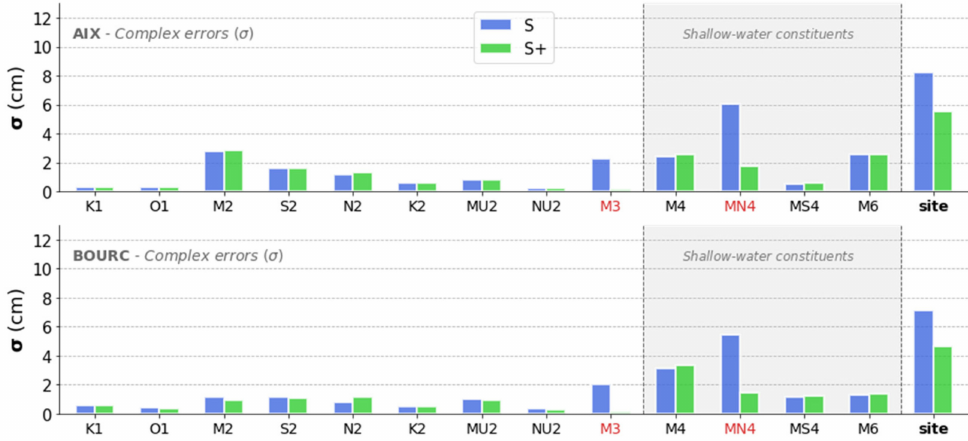
Figure 7. Complex errors for the 13 major constituents at AIX ( top panel ) and BOURC ( bottom panel ) stations. For each constituent, errors associated to each configuration is represented: S (blue) and S+ (green). The last bar chart (right) represents the combined complex error for 13 constituents. Red labels correspond to constituents for which an empirical bias has been applied on the S+ forcing, and the bold right chart is the combined complex error for 13 constituents at the